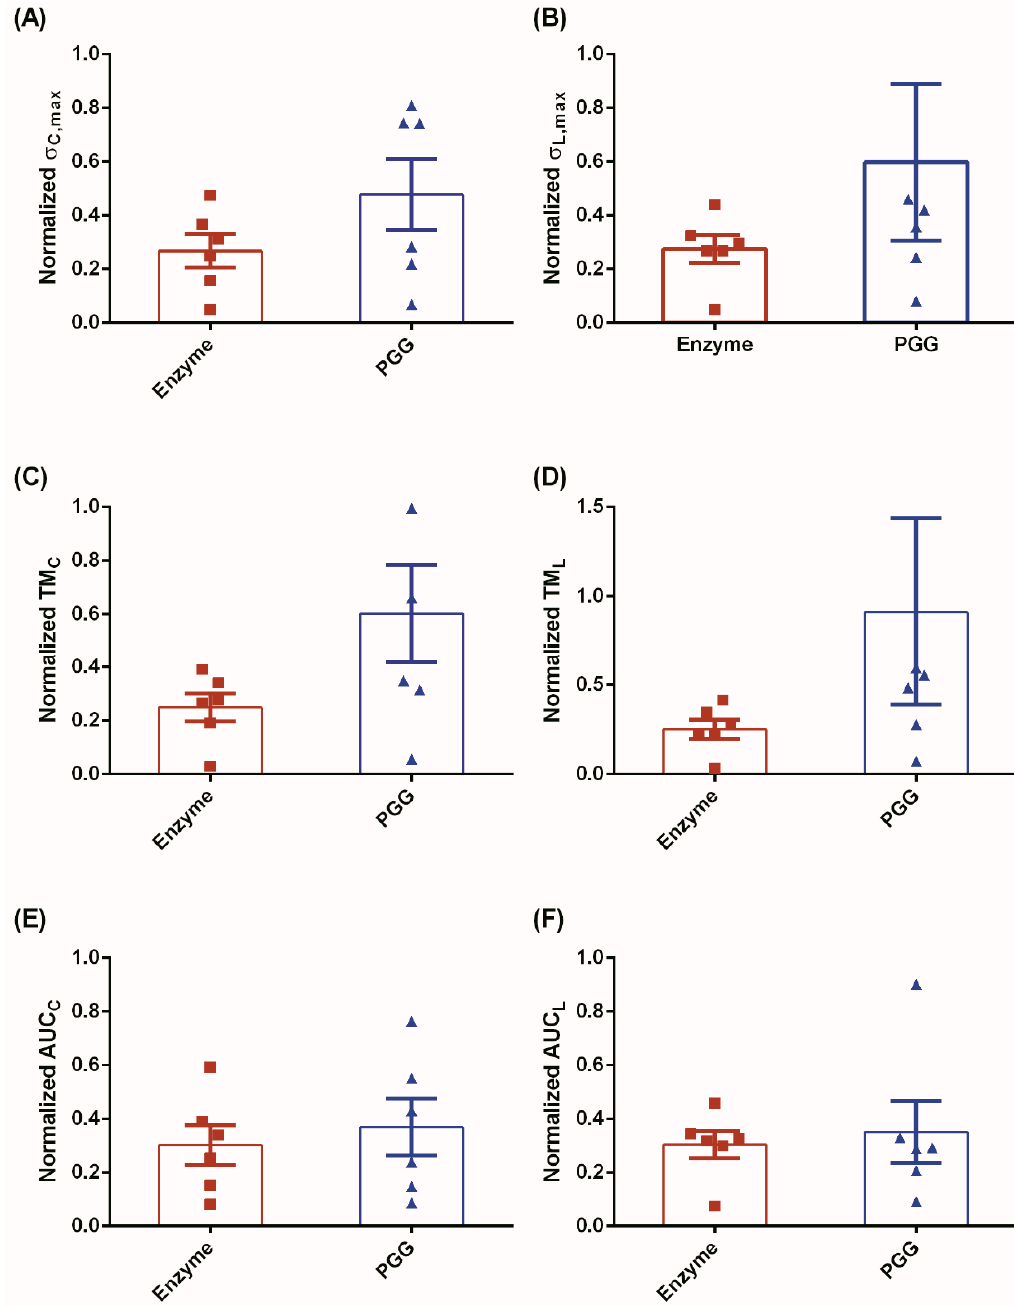
Figure 5. An assessment of the recovery of biomechanical properties by normalizing the enzymatic- and PGG-based biomechanical parameters to their native equivalents. We observe an increasing trend in σ max ( A , B ) and TM ( C , D ) for both circumferential and longitudinal orientations, respectively. AUC for both orientations exhibited similar but limited increase in strain energy ( E , F ), thereby indicating a conservation of elastic energy.